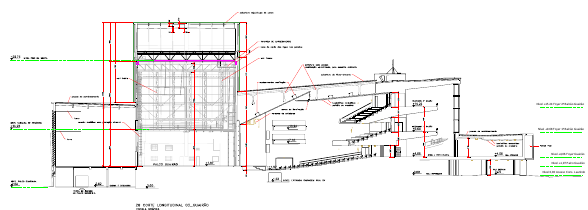
Figure 3. Big Auditorium “Guairão” Longitudinal Section